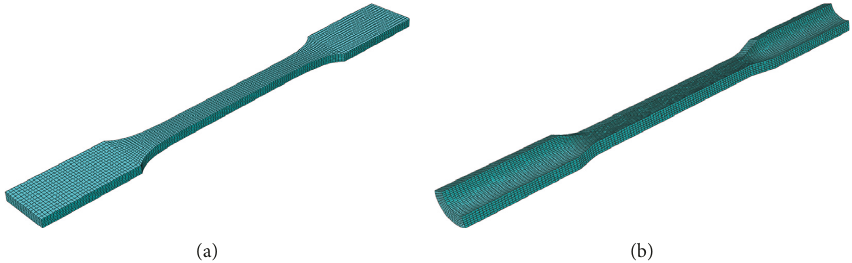
Figure 16: FE models of flat and corner coupons: (a) flat coupon; (b) corner coupon.